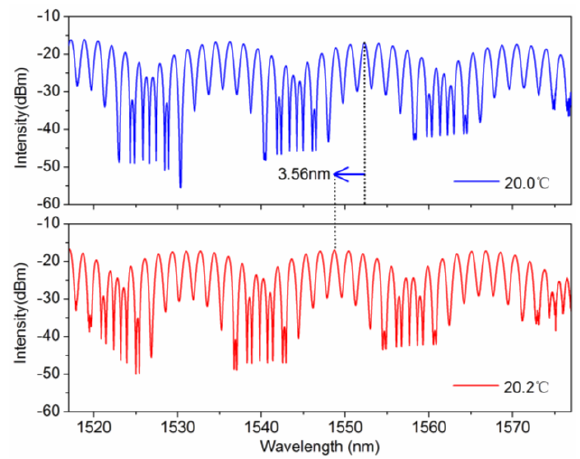
Figure 5. Spectra of Lyot-Sagnac sensor at the 20.0 °C and 20.2 °C.